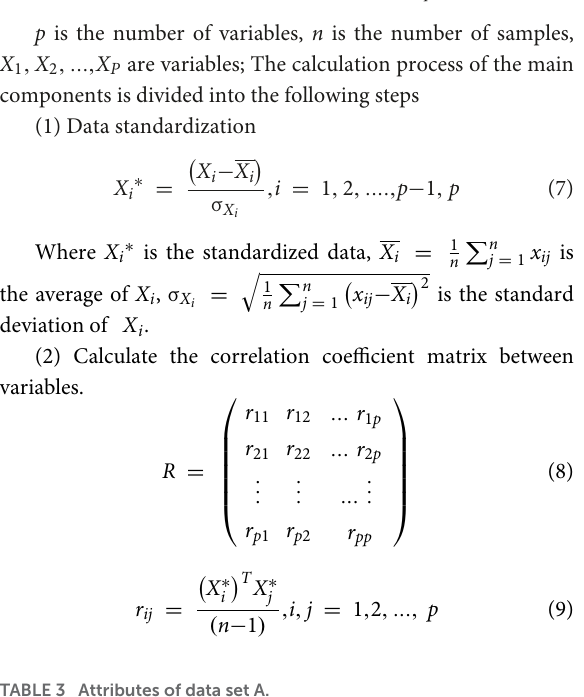
TABLE 3 Attributes of data set